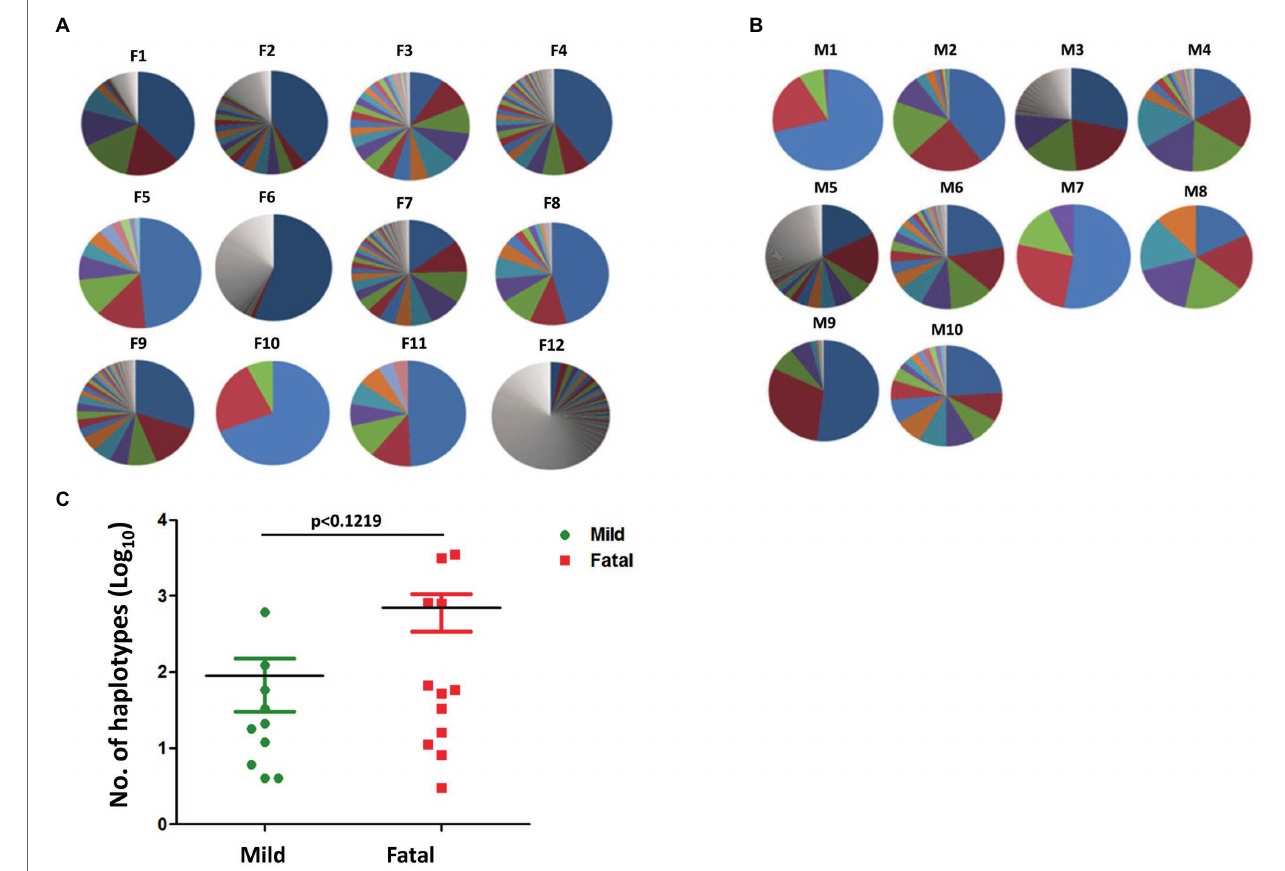
FIGURE 1 | Haplotypes of mild and fatal cases. Proportion of haplotypes within each isolate in both (A) fatal and (B) mild cases. Each pie chart represents a single isolate. The different sections within the chart each represent a percentage of a haplotype, whereby the bigger the section the higher the percentage. The major haplotype is represented by the section with the highest percentage. Similar section color does not represent the same haplotype and does not represent similar sequence. Each section represents a single individual haplotype. (C) The number of haplotypes between mild (green) and fatal (red) cases. Each point represents a single isolate. Student’s t -test, p <